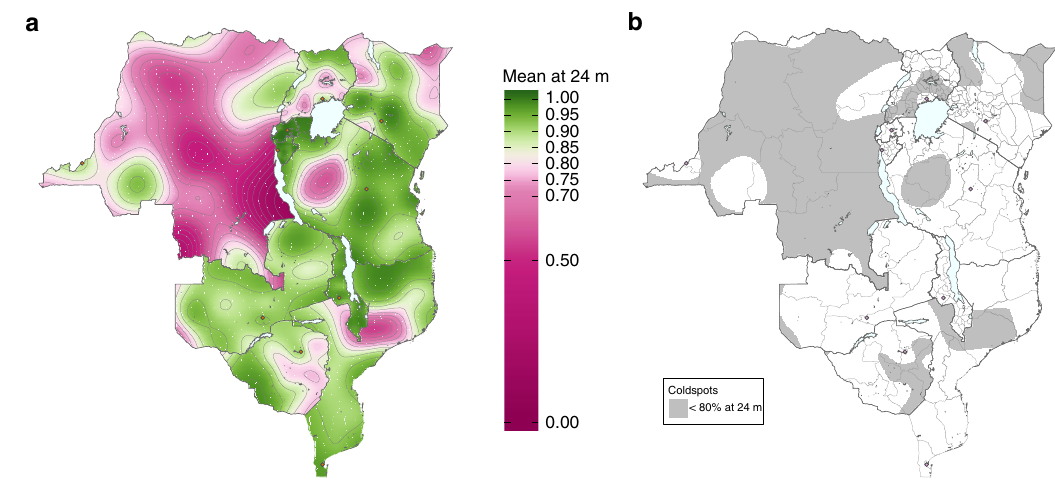
Figure 1 | Vaccination coverage and coldspots at 24 months of age. ( a ) Estimated mean proportion of children 24 months of age who have either received routine measles vaccination or were vaccinated during a national measles SIA campaign. Contour lines are marked at every 0.05 level. Capital cities are shown as orange circles. ( b ) Estimated coldspots (defined as below 80% estimated mean measles vaccination coverage) of routine and national SIA measles vaccination for children 24 months of age. Capital cities are shown as pink circles. The first sub-national political boundaries are shown in light grey.